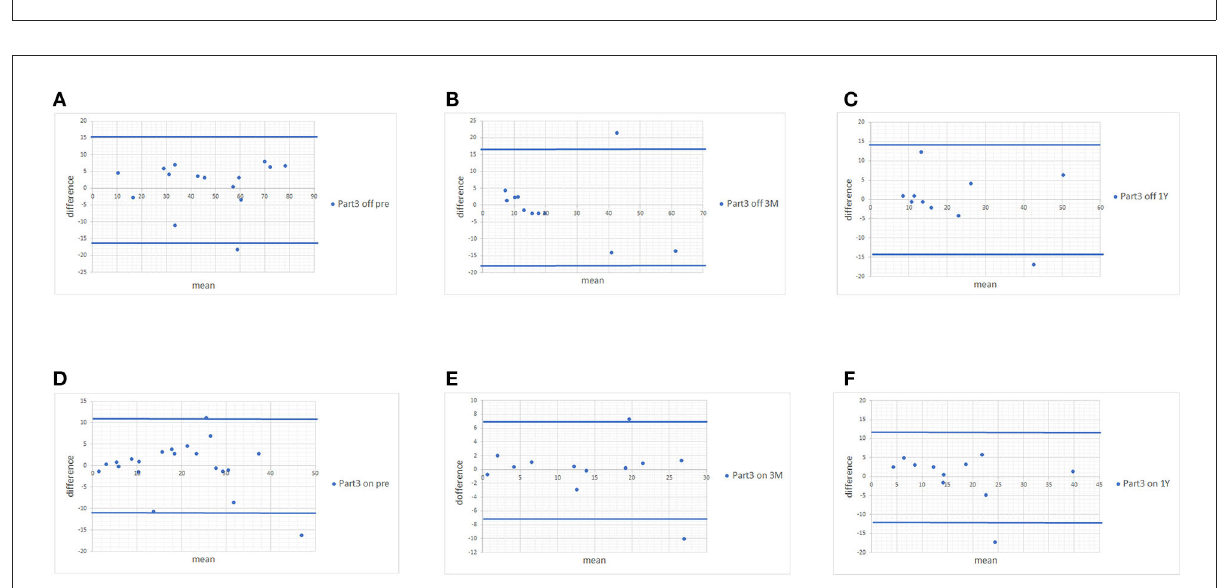
FIGURE2 Bland-Altman plots of MDS-UPDRS Part III scores and scores estimated from the UPDRS. (A) Pre-operative MDS-UPDRS during the off phase. (B) Post-operative MDS-UPDRS 3 months after surgery during the off phase. (C) Post-operative MDS-UPDRS 1 year after surgery during the off phase. (D) Pre-operative MDS-UPDRS during the on phase. (E) Post-operative MDS-UPDRS 3 months after surgery during the on phase. (F) Post-operative MDS-UPDRS 1 year after surgery during the on phase. The means of the two scores are displayed on the x-axis, and the difference between the score is displayed on the y-axis. The two blue lines represent the limits of agreement (average difference ± 1.96 standard deviation of the difference).